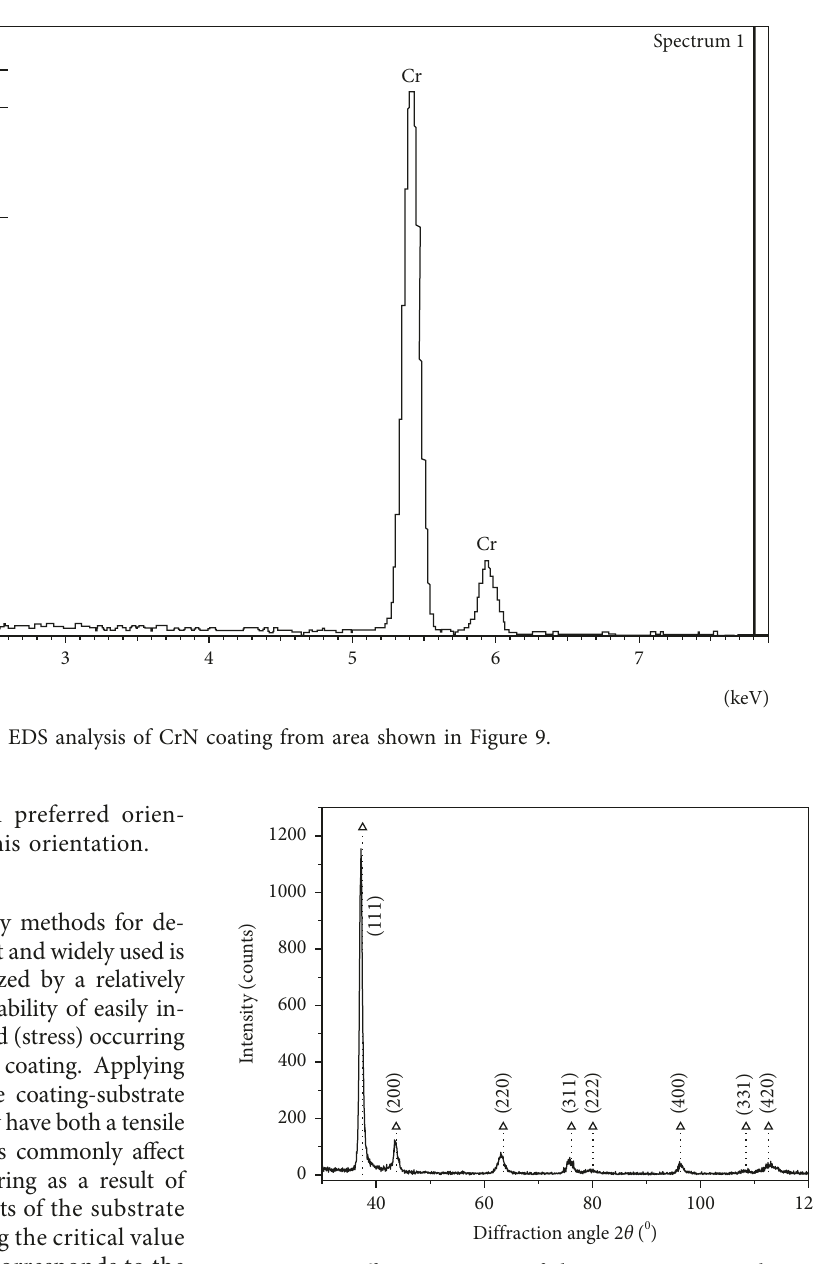
Figure 12: Diffraction pattern of the CrN coating on the steel 42CrMo4 substrate. Table 2: The Tc(hkl) texture coefficient for CrN